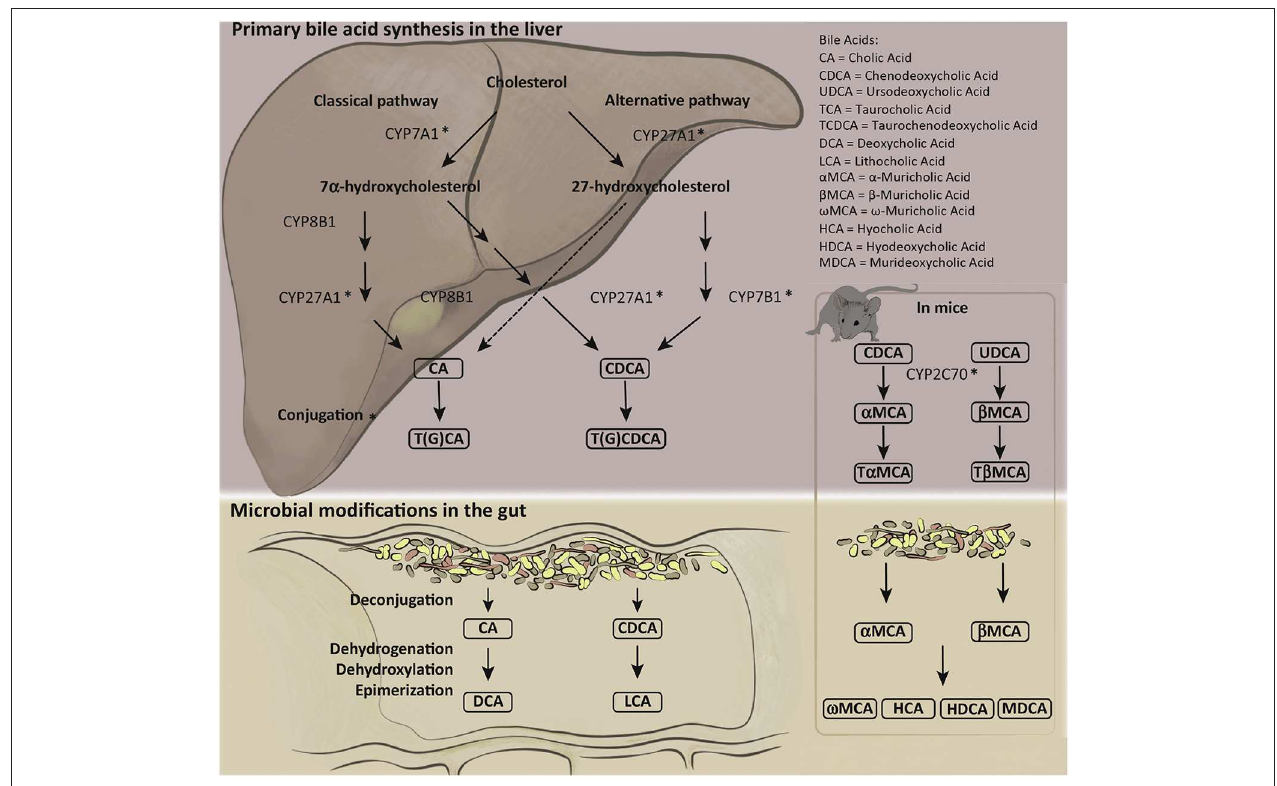
FIGURE 1 | Human and mouse bile acid synthesis and conjugation. Cholesterol catabolism results in the creation of primary bile acids (BAs) through either the classical pathway, accomplished by Cytochrome P450 7A1 (CYP7A1), or the alternative/acidic pathway, conducted by Cytochrome P450 27A1 (CYP27A1). Alteration by various cytochrome P450 family of enzymes allows for the creation of cholic acid (CA) and chenodeoxycholic acid (CDCA). Primary BAs can become conjugated to glycine or taurine prior to secretion to the biliary ductules. Deconjugation and reconjugation occurs in the distal ileum through bacterial intervention creating secondary BAs: lithocholic acid (LCA) or deoxycholic acid (DCA). Mice have additional primary BAs: Ursodeoxycholic acid (UDCA) and α - and β -muricholic acid. The murine specific primary BAs created by cytochrome P450 2C70 (CYP2C70) can also be conjugated to glycine or taurine prior to secretion into bile duct and alteration by gut microbiota into secondary BAs. Figure reprinted with permission from Molinaro et al. Trends Endocrinol